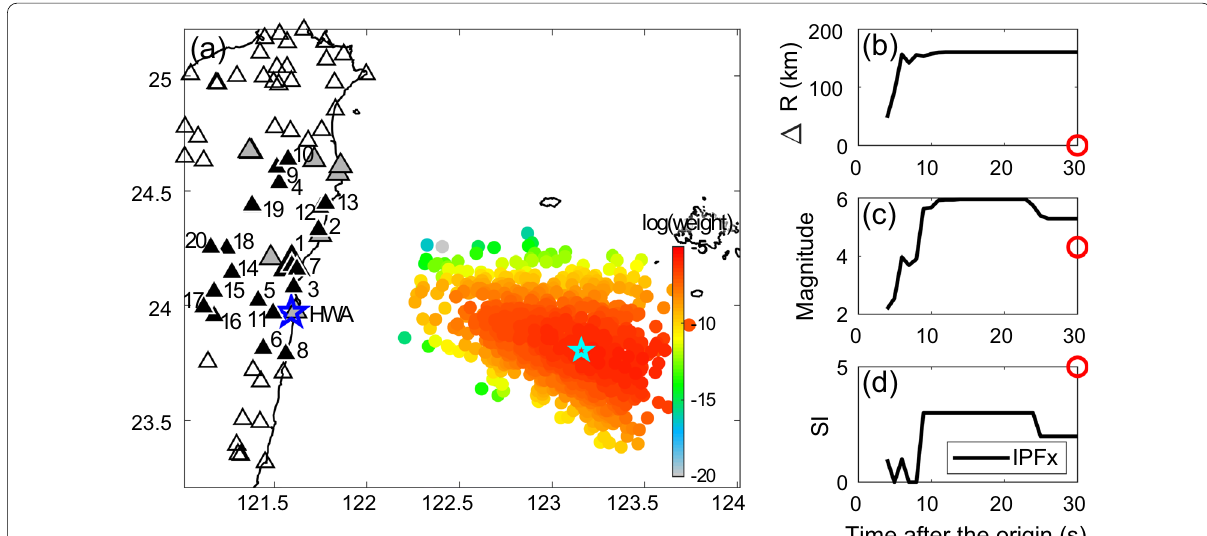
Fig. 5 Result of the M 4.3 aftershock on February 6, 2018. The format is the same as in Fig. 4. The numbers in ( a ) indicate the order in which the triggers contributed to the source estimation